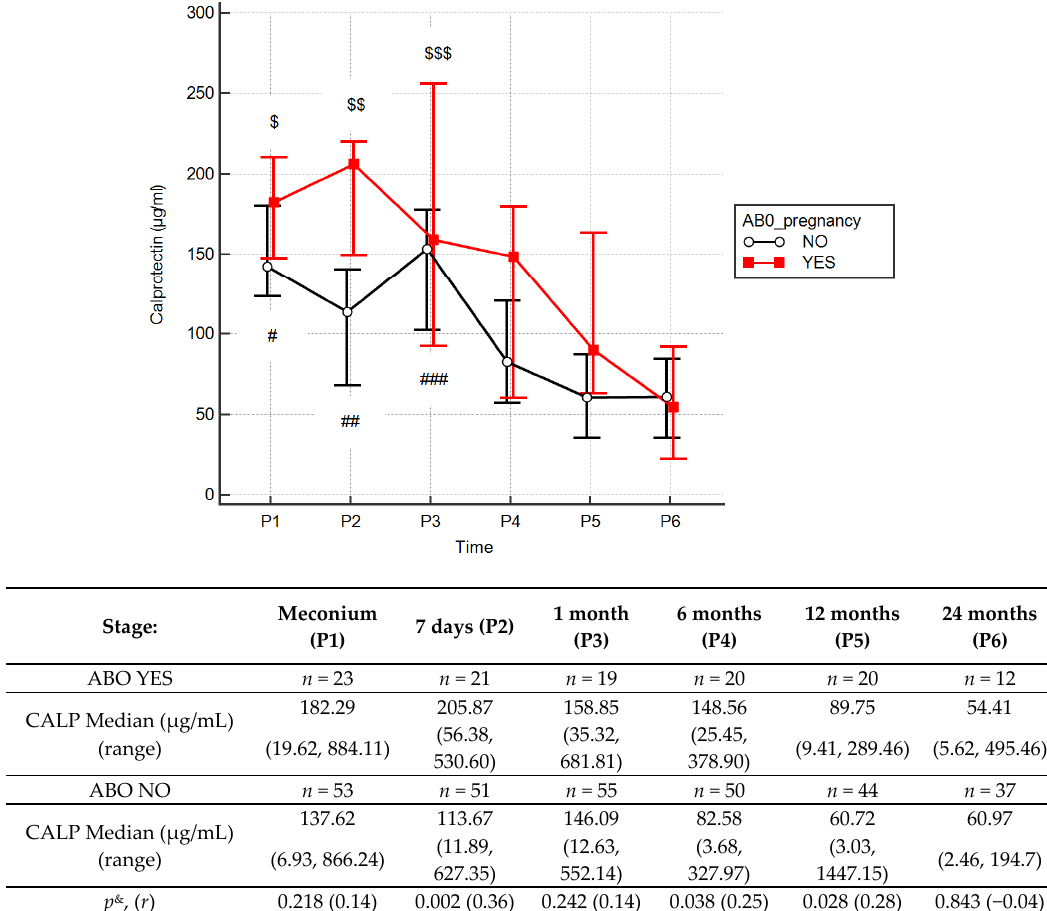
Figure 4. Calprotectin (CALP) concentrations (median) in children over time with (red line) or without (black line) antibiotic therapy during pregnancy (ABO). Legend: Error bars represent 95% confidence intervals for medians. p & = Mann–Whitney test comparing e ff ects of antibiotics (ABO), r = e ff ect